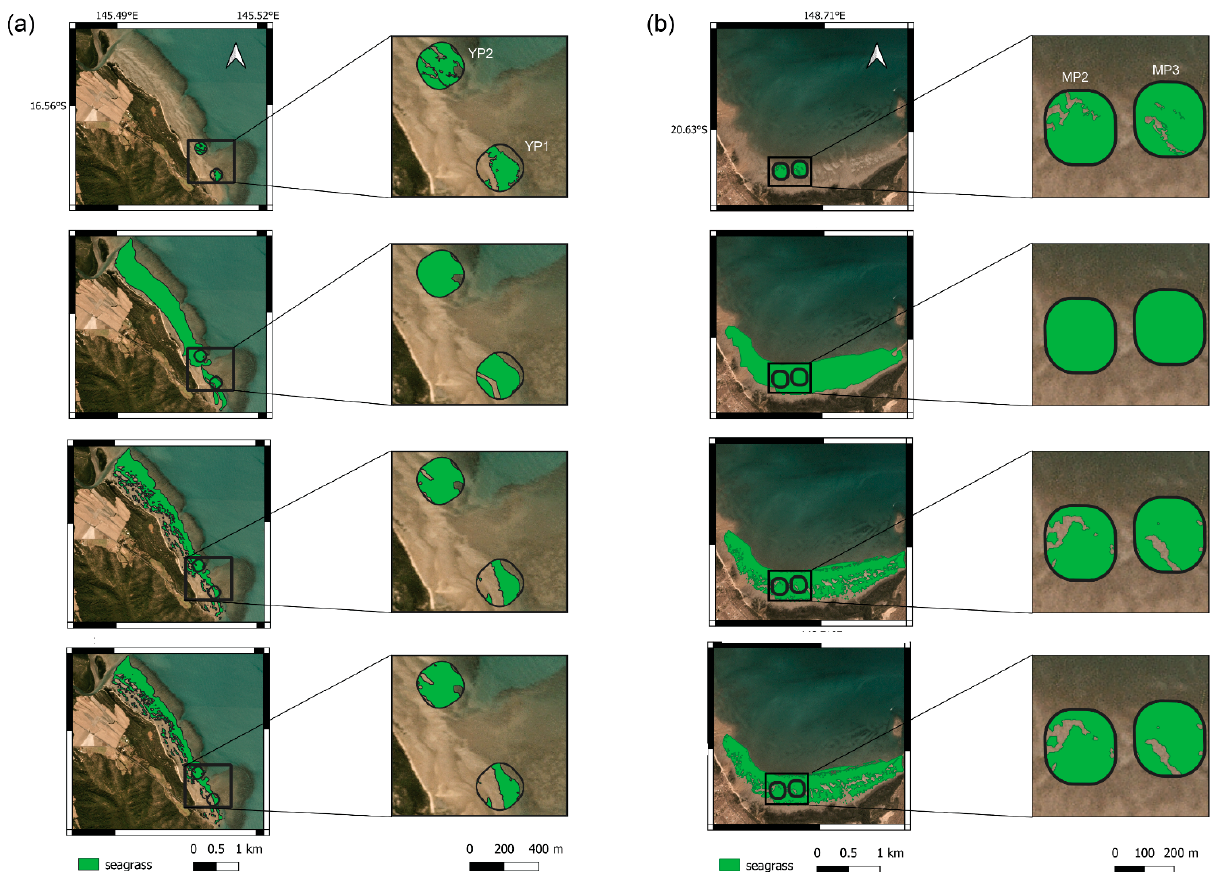
Figure 8. Comparison of traditional (in situ by foot and high earth by helicopter) and enhanced (spaceborne) approaches to mapping extent of coastal seagrass communities at meso ‐ and fine ‐ scales in 2017 within the GBRWHA: ( a ) coastal clear water Halodule uninervis with Halophila ovalis meadows at Yule Point in 2017; ( b ) coastal turbid water Zostera muelleri meadows at Midge Point in 2017. Left column is meso ‐ scale across banks, and right column is fine ‐ scales within sites. From top: row 1, direct in situ by foot; row 2, high earth by helicopter; row 3, spaceborne by satellite, showing 100% bootstrap probability; and bottom row, spaceborne by satellite, showing 60% bootstrap probability.